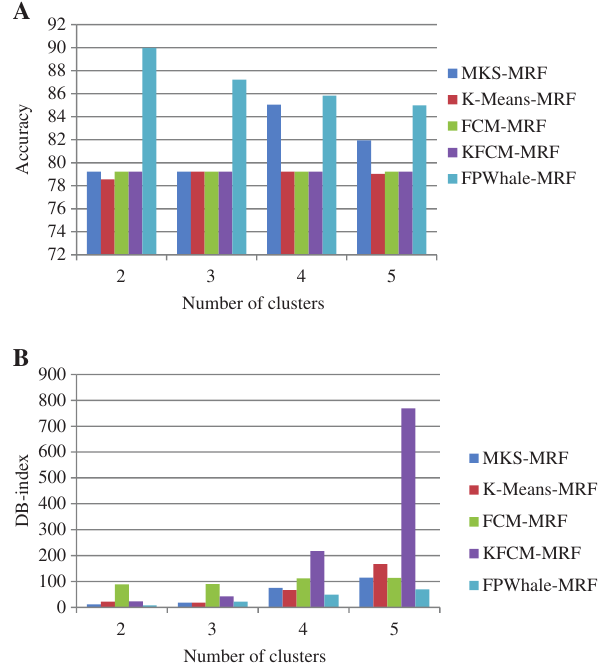
Figure 5: Comparative Analysis Using Dataset 2: (A) Accuracy and (B)